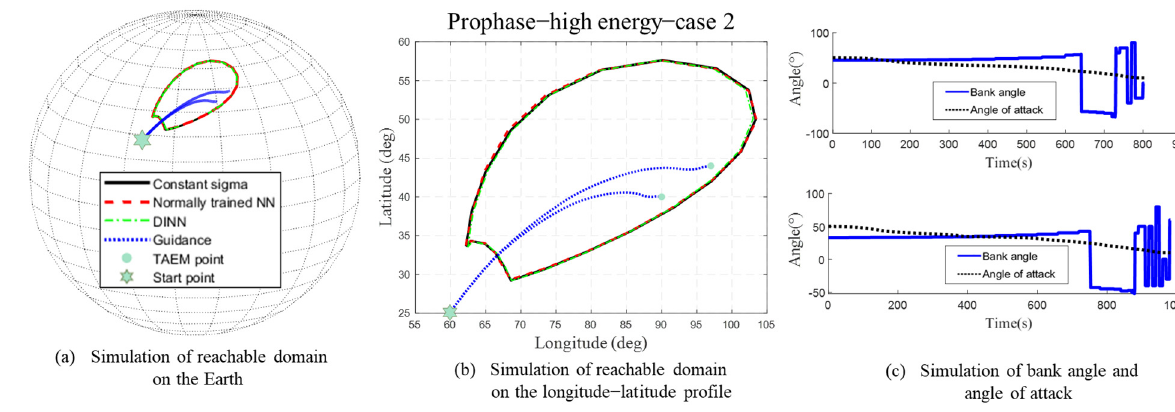
Figure 7. Simulation of high energy Case 2.